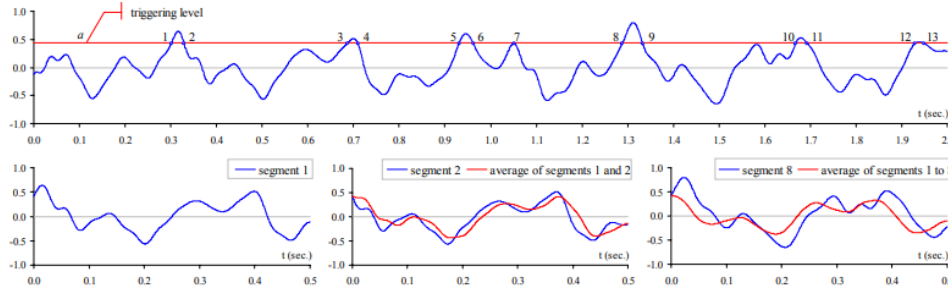
Figure 1. The analysis procedure for Random Decrement Technique [4].